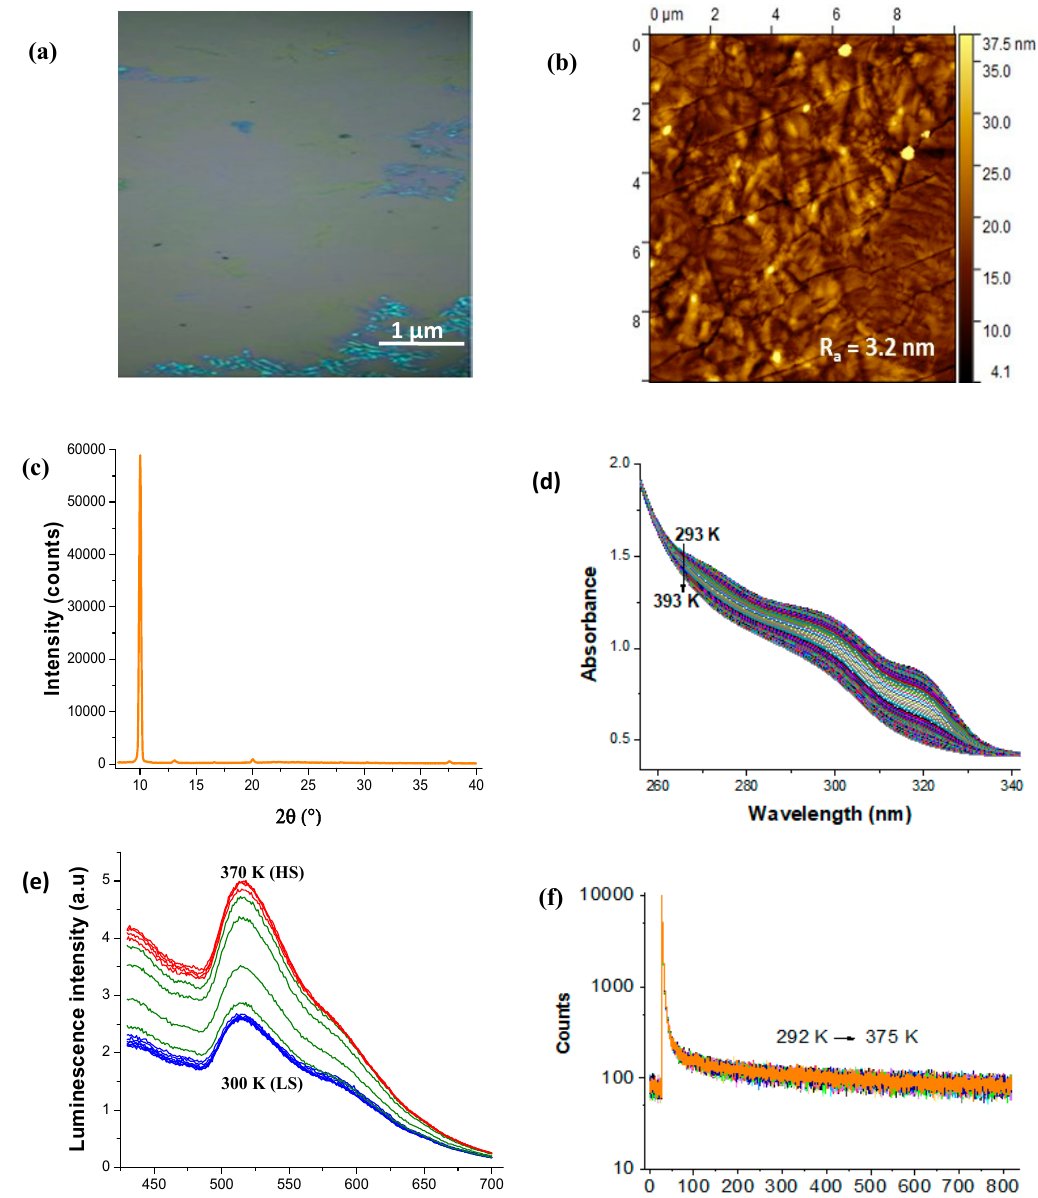
Figure 2. Characterization of bilayer films of Ir(PPy) 3 and [Fe(HB(tz) 3 ) 2 ]. Typical optical microscopy ( a ) and AFM topography ( b ) images, ( c ) GIXRD pattern, ( d ) variable temperature UV absorption spectra, ( e ) variable temperature luminescence emission spectra (excitation: 300 nm, high pass filter λ emission > 400 nm) and ( f ) variable temperature luminescence decay curves (excitation: 303 nm, emission 520 nm) recorded over the first 800 ns of the decay.